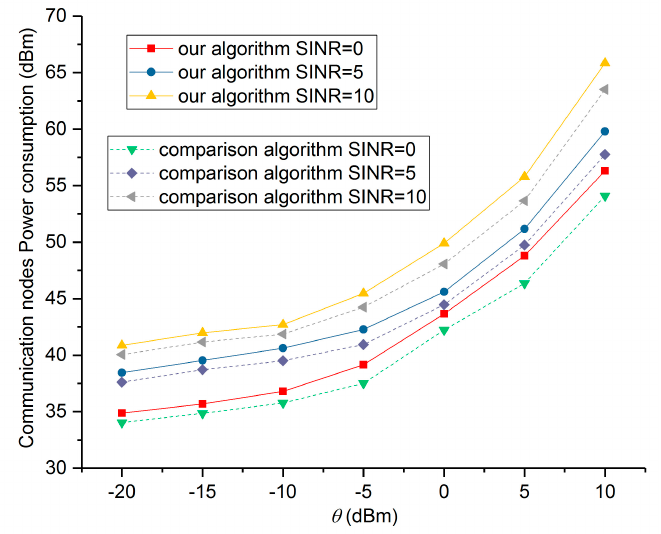
Figure 7. Communication nodes’ power consumption comparison with different SINR thresholds.